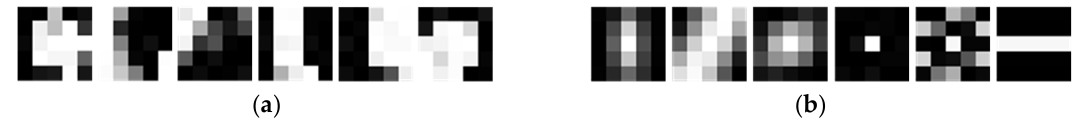
Figure 7. ( a ) Visualization of part of the conventional trained kernels and ( b ) optimized Gabor kernels of the first convolutional layer (with θ = 0°, 30°, 60°, 90°, 120°, and 150°).